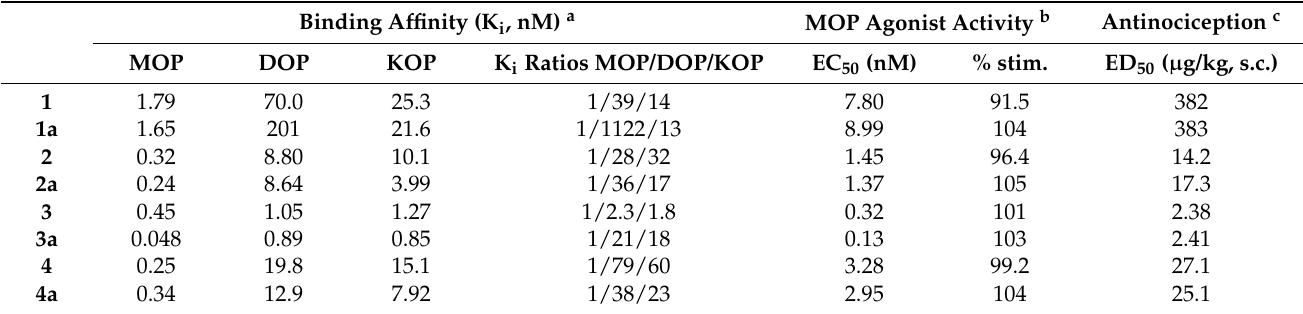
Table 1. In vitro and in vivo opioid activity of N -methylmorphinan-6-ones 1 – 4 and their 6-desoxo counterparts 1a – 4a